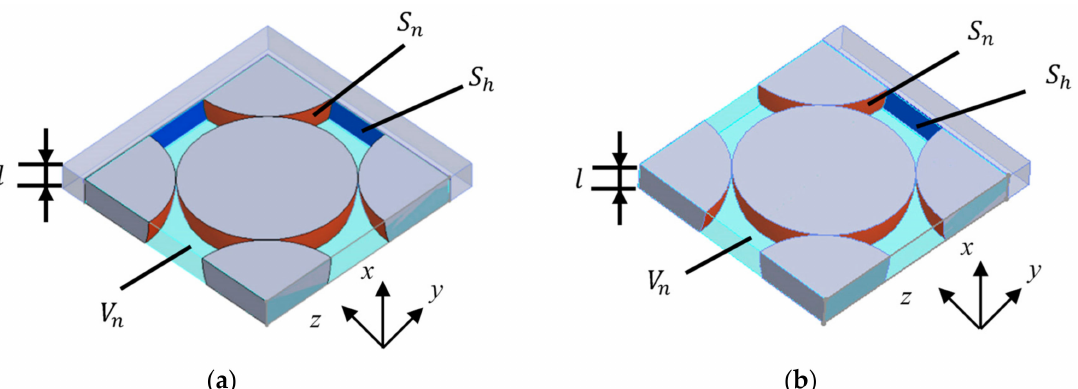
Figure 8. Approximated clearance between two planes at the element in contact with the sample holder: ( a ) Divided element in contact with the sample holder on two sides; ( b ) Divided element in contact with the sample holder on one